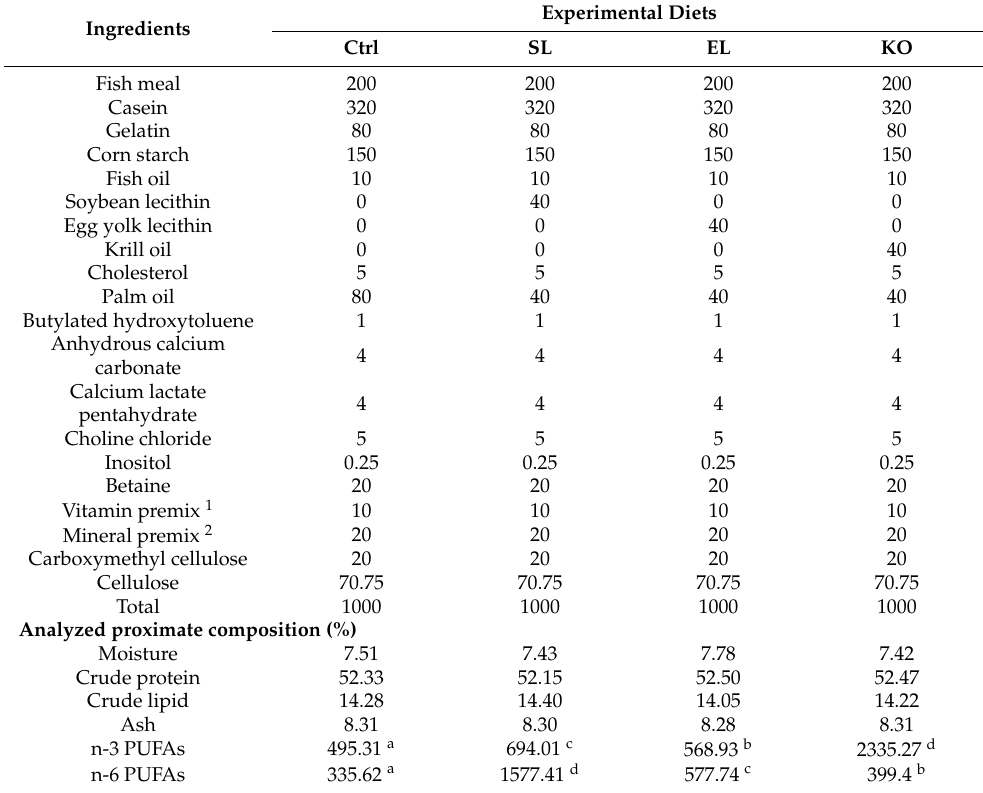
Table 1. Formulation (g/kg dry basis), proximate composition (%), and statistical analysis of differ- ences for PUFAs contents of the experimental diets fed to female L. vannamei